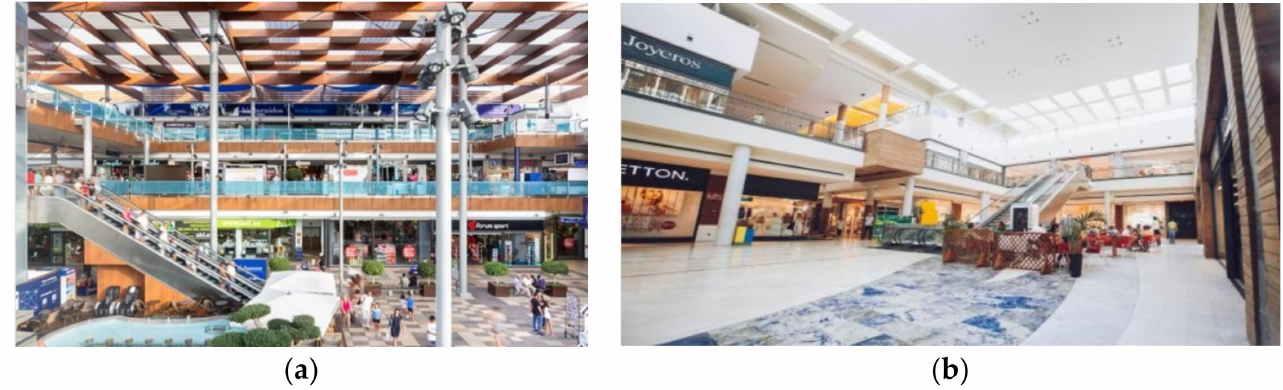
Figure 4. Panoramic image of each of the shopping malls where the IPS has been evaluated: ( a ) mall 1 has three floors and a wooden, cloth-covered roof structure, ( b ) mall 2 has two